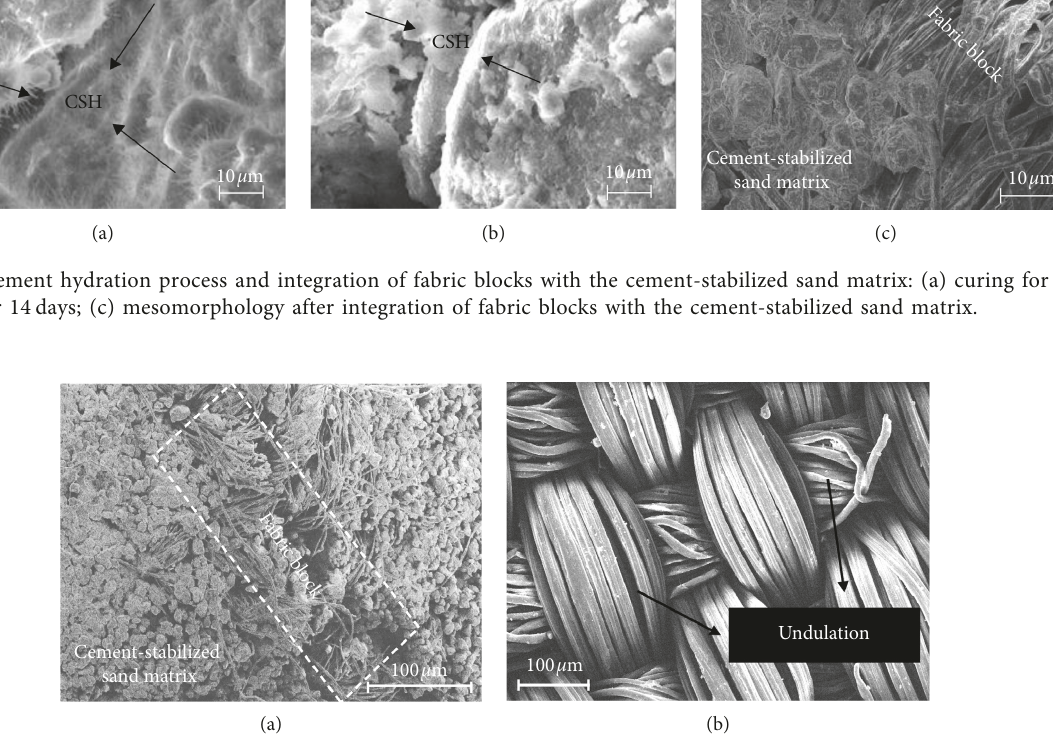
Figure 14: (a) Distribution pattern of fabric blocks in cement-stabilized sand; (b) surface morphology of fabric blocks.